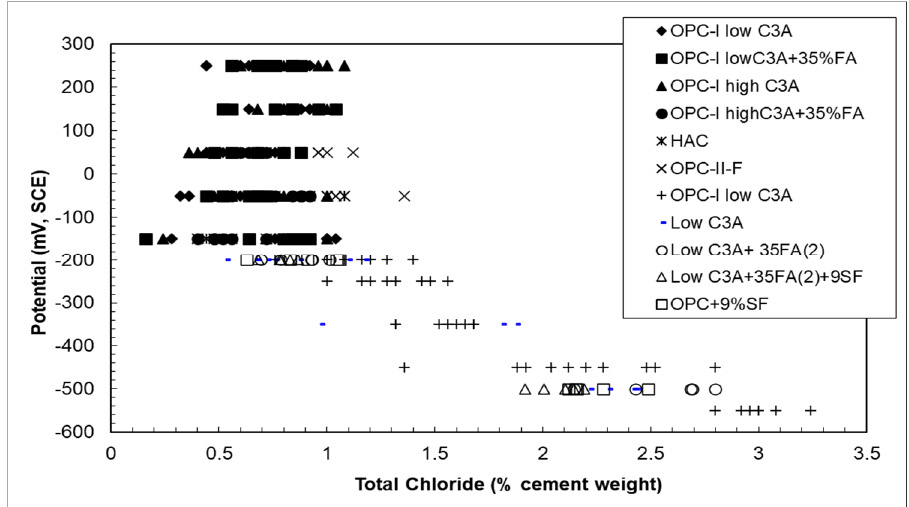
Figure 1. Values of chloride thresholds (by weight of cement) [14,15] for different types of binders and the potentials applied. The values at each potential indicate the individual values of 10 twin specimens tested for the same potential and binder type.